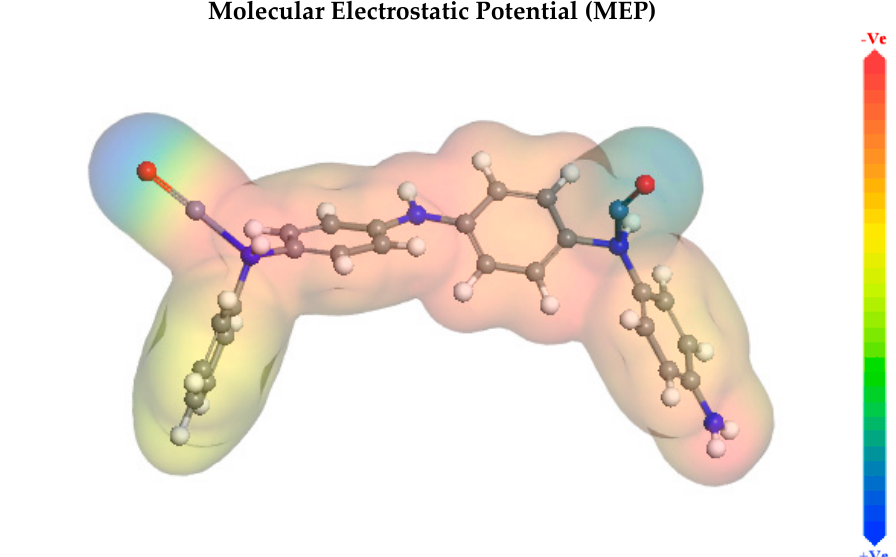
Figure 11. Molecular Electrostatic Potential (MEP) of the studied ZnNiO@PANE molecule.